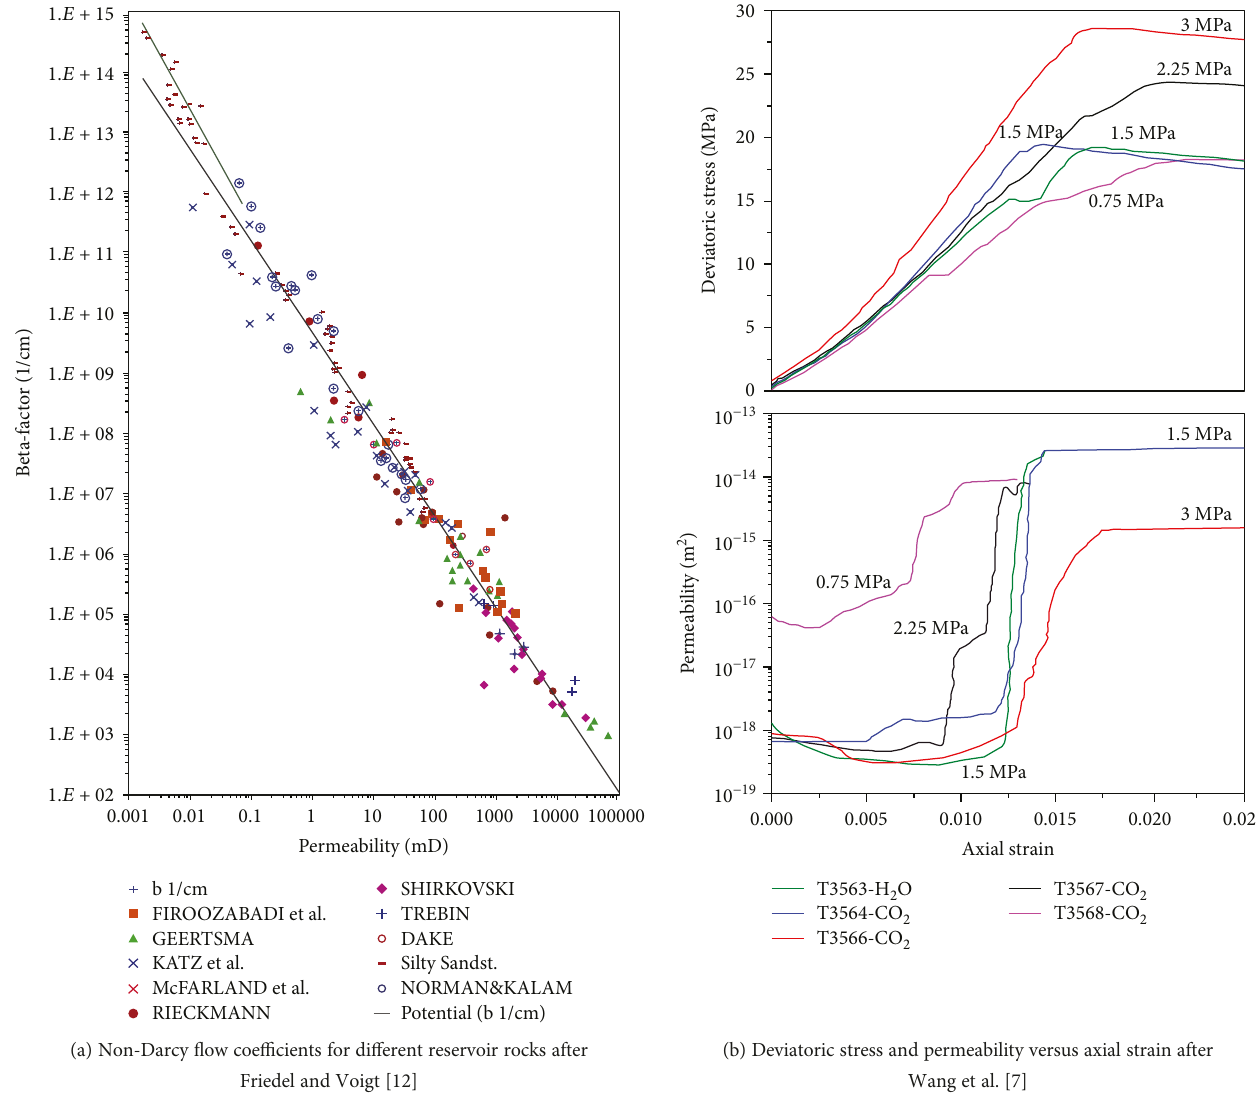
Figure 3: Non-Darcy fl ow coe ffi cients for di ff erent reservoir rocks and coal permeability evolution during progressive deformation [7,